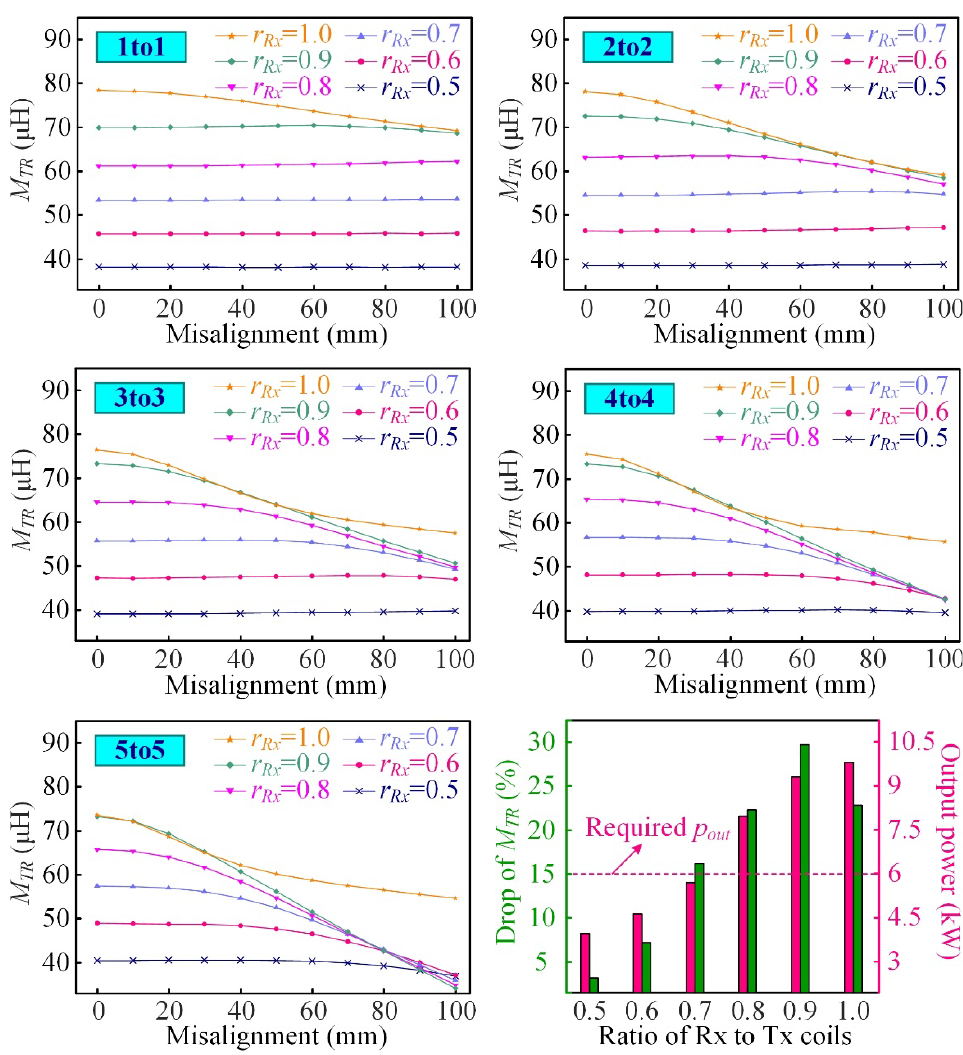
Figure 9. Variation of mutual inductance versus 0-to-100 mm horizontal misalignment with different numbers of coil pairs and different ratios of size of Rx coils to Tx coils.